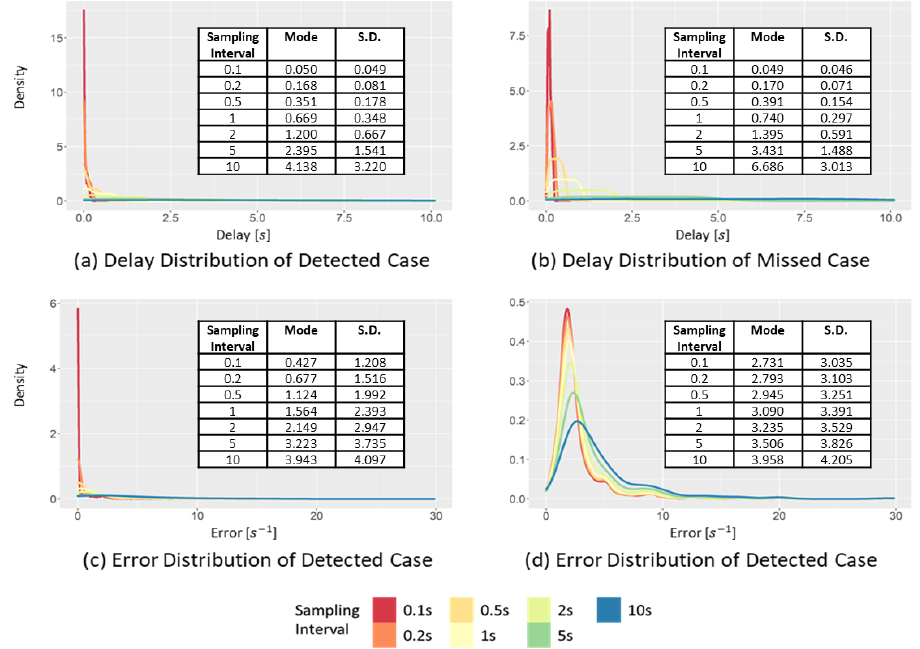
Figure 15. Changes in the delay and error distribution of the ITTC in the detected case and missed case, varying the sampling intervals.